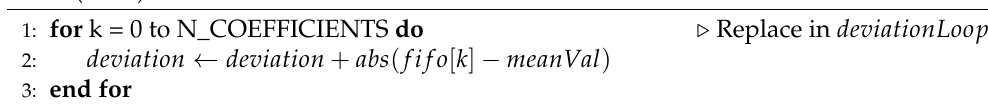
Algorithm A3 Pseudocode snippet of standardization (MAD) for simplified correlation index